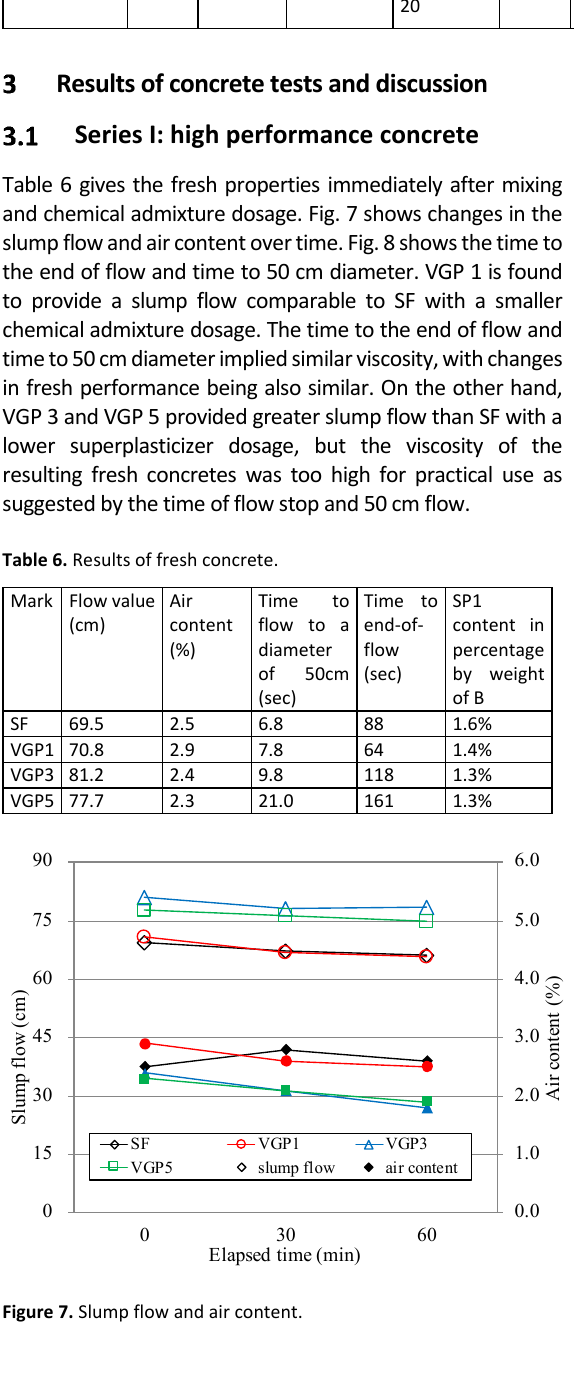
Figure 8. Time of 50cm flow (top) and flow stop